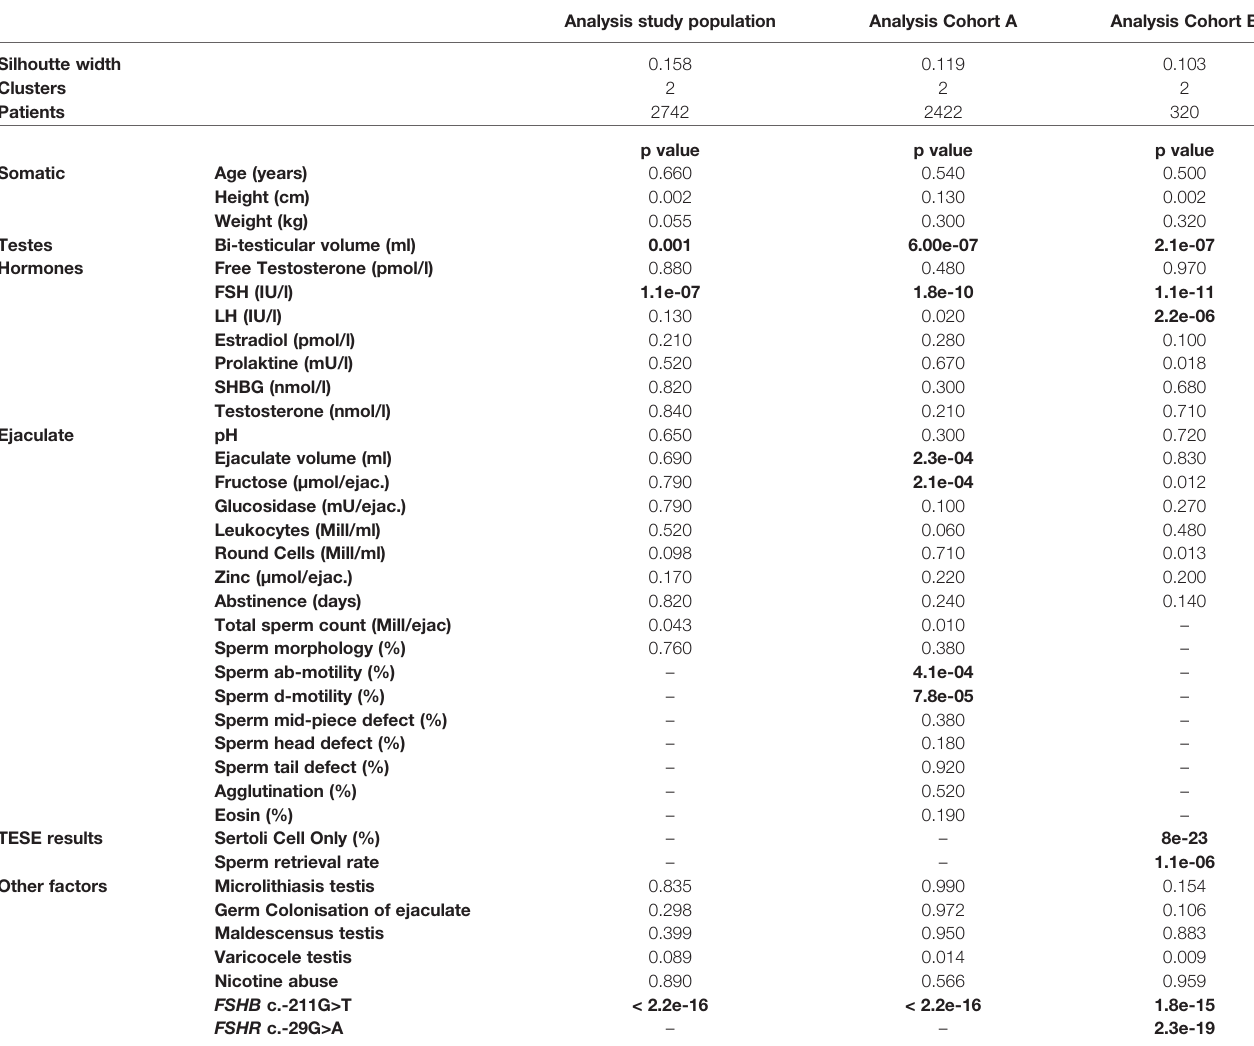
TABLE 2 | Survey of all andrologic/histologic parameters that were included in the cluster analysis, and the respective p